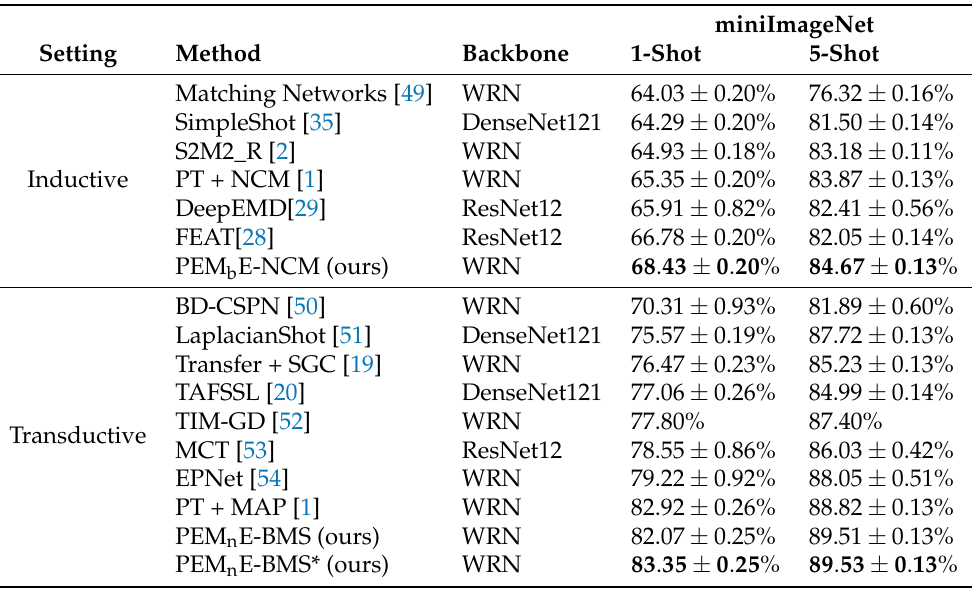
Table 1. The 1-shot and 5-shot accuracy of state-of-the-art methods in the literature on miniImageNet and tieredImageNet, compared with the proposed solution. Best results are in